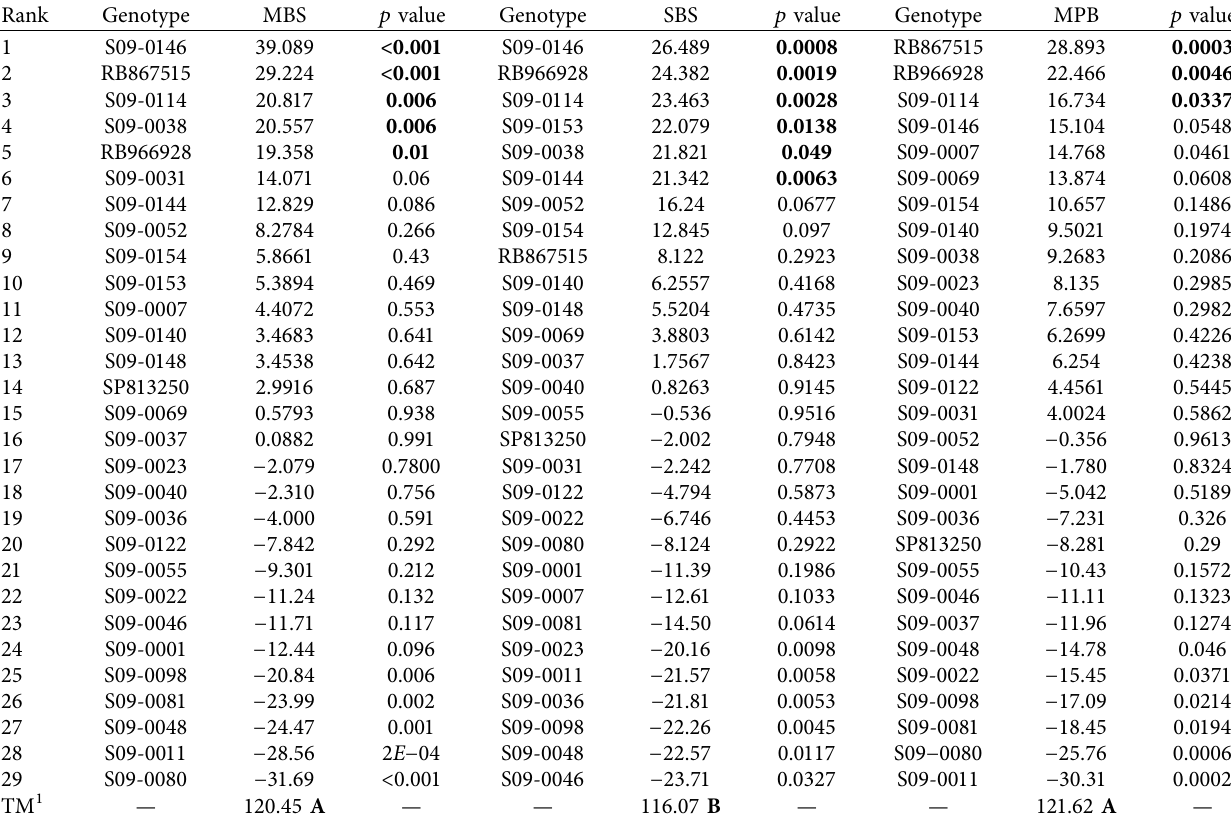
Table 6: Predicted genotypic differences (PGD) for TCH across 29 genotypes (mean plant cane and 1st ratoon TCH) and three planting material types (MBS, SBS, or